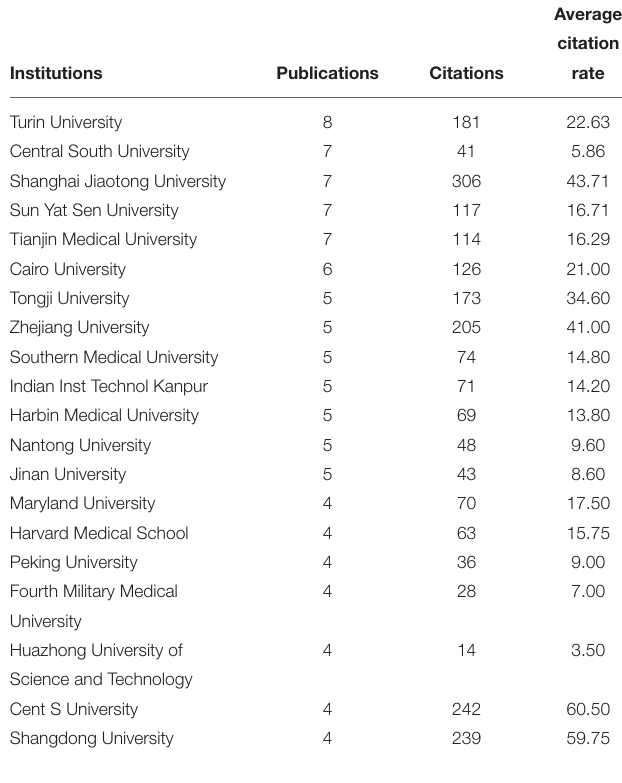
TABLE 2 | The top 20 institutions with the most publications in the field of SC-EVs for